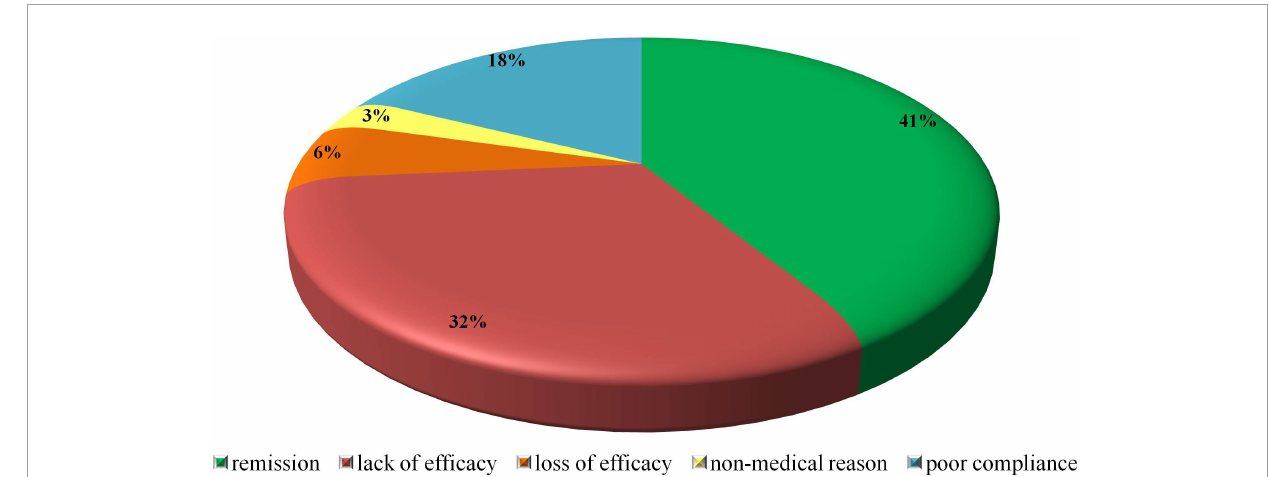
FIGURE2 Reasons for SSK12 discontinuation in patients with PFAPA syndrome enrolled in the AIDA registry participating in the